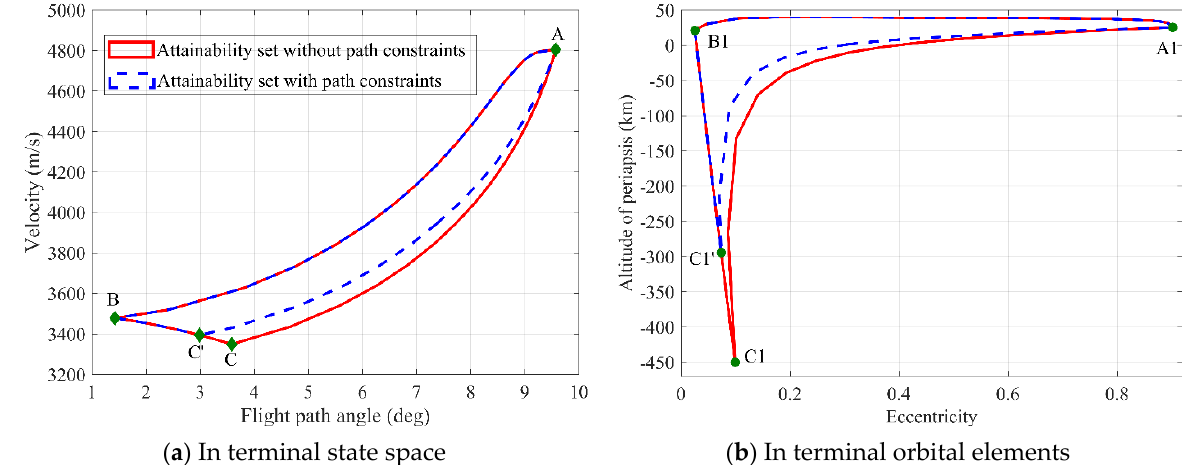
Figure 13. Aerocapture attainability sets with and without path constraints.